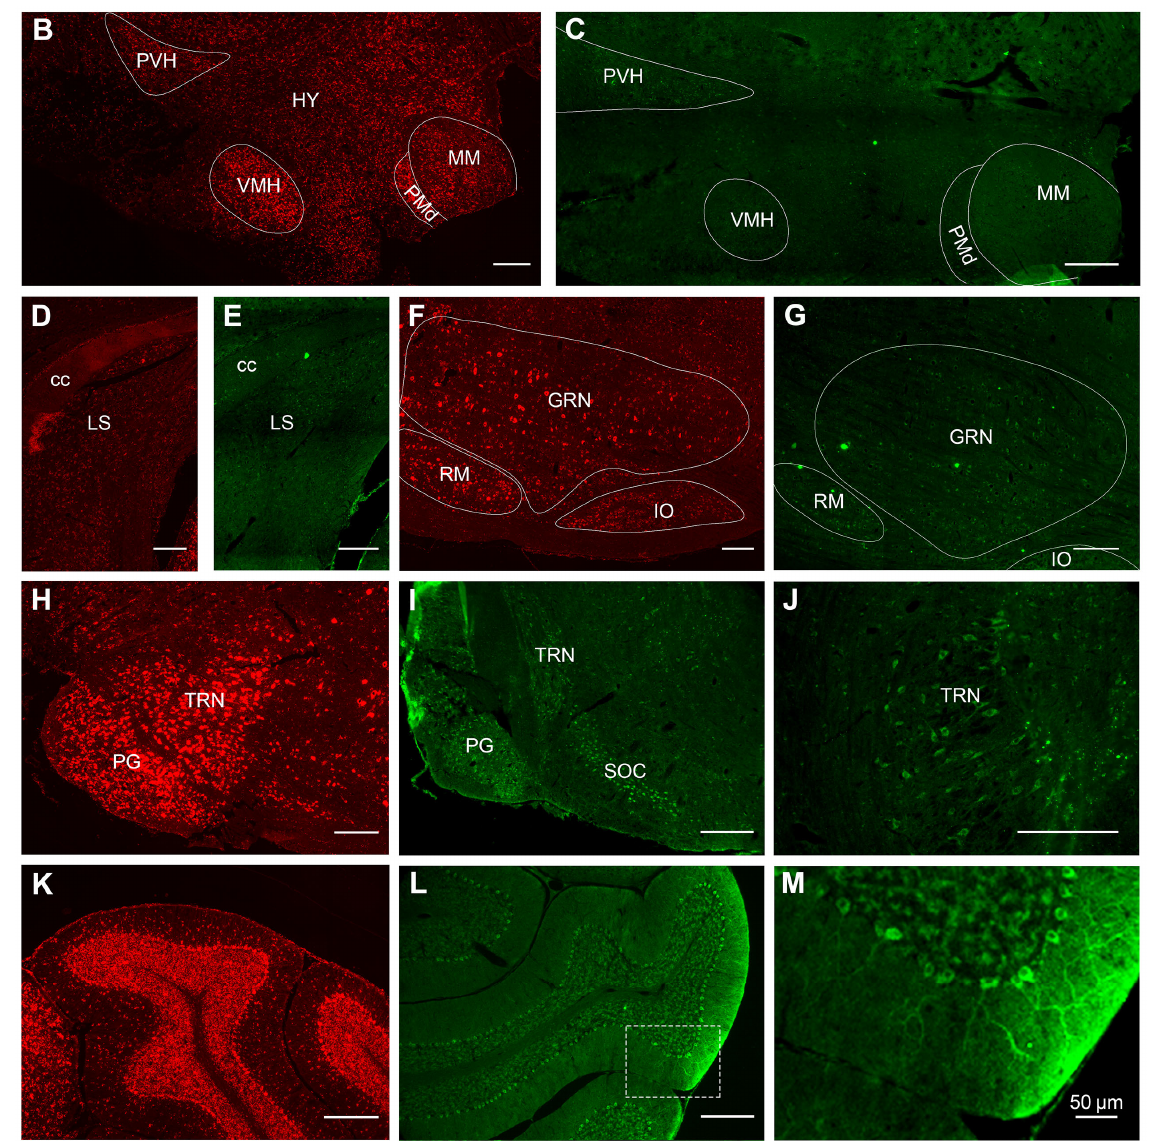
Figure 4. VPS13A mRNA and protein are widely localized in subcortical and non ‐ basal ganglia nuclei of the adult mouse brain. ( A ) Drawing with the location of the different brain regions shown in ( B – M ). Specific labeling of VPS13A mRNA (red) and protein (green) in the representative sagittal section of the mouse brain. Specific brain regions with detected expression were ( B , C ) hypothalamus, ( D , E ) lateral septum, ( F , G ) medulla, ( H – J ) pons, and ( K – M ) cerebellum. PVH, paraventricular hypothalamic nucleus; HY, hypothalamus; VMH, ventromedial hypothalamic nucleus; PMd, ventral premammillary nucleus; MM, medial mammillary nucleus; cc, corpus callosum; LS, lateral septum; RM, nucleus raphe magnus; GRN, gigantocellular reticular nucleus; IO, inferior olivary complex; PG, pontine gray; TRN, tegmental reticular nucleus; and SOC, superior olivary complex. n = 3. Scale bar 250 μ m.